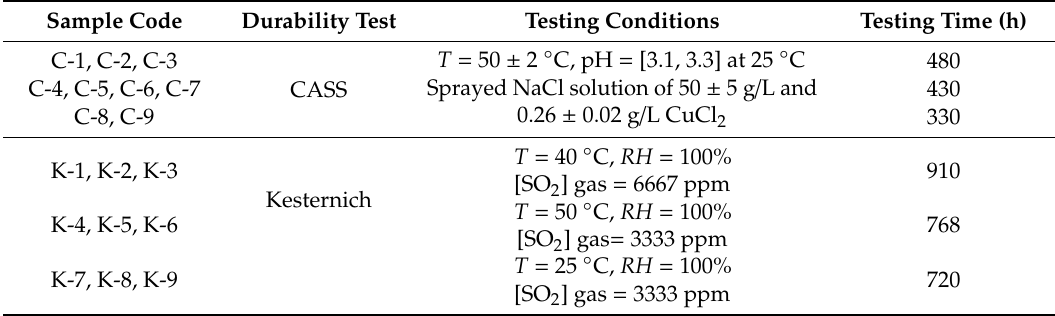
Table 2. Tests conditions of the experiments applied to the studied reflector